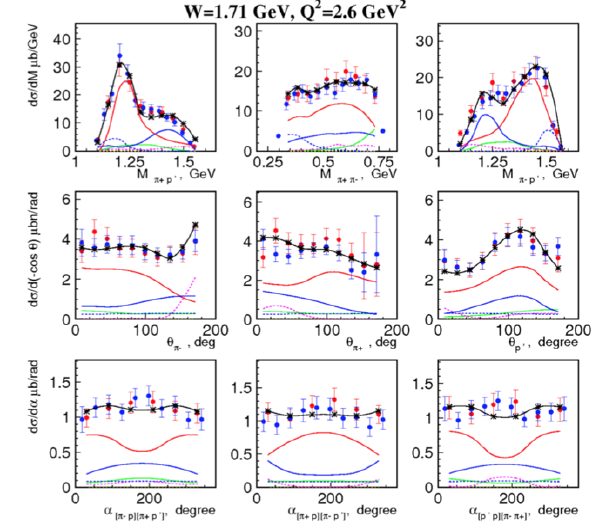
Fig. 2. (Color online) Single pion electroproduction g v p ® n p + cross sections [9] for Q 2 = 2.05 GeV 2 with model fits [10] (red solid line – DR, blue solid line – UIM, red dotted – DR without N(1440)1/2 + contribution). Fig. 4. (Color online) Two pion electroproduction 1-fold differential cross sections for W = 1.71 GeV, Q 2 = 2.6 GeV 2 with JM model fits (black solid